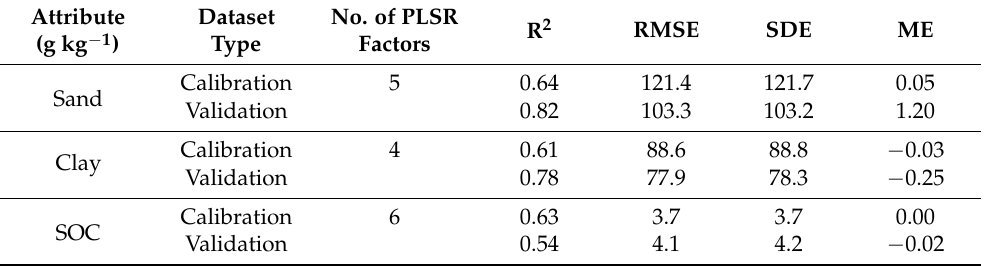
Figure 9. Relationships between measured and predicted sand, with dots representing validation examples in accordance with Tables 3 and 4. Figure 10. Relationships between measured and predicted clay, with dots representing validation examples in accordance with Tables 3 and 4.